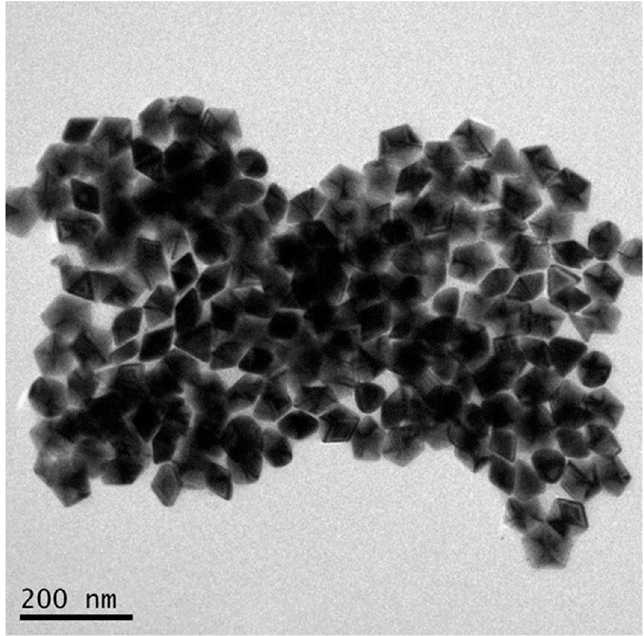
Figure 10. TEM image of AgNPs reconstructed under blue LEDs for 1 h at 60 °C (using blunt D-AgNPs as seeds), followed by the irradiation under green LEDs (35 mW/cm 2 ) for 3 h.